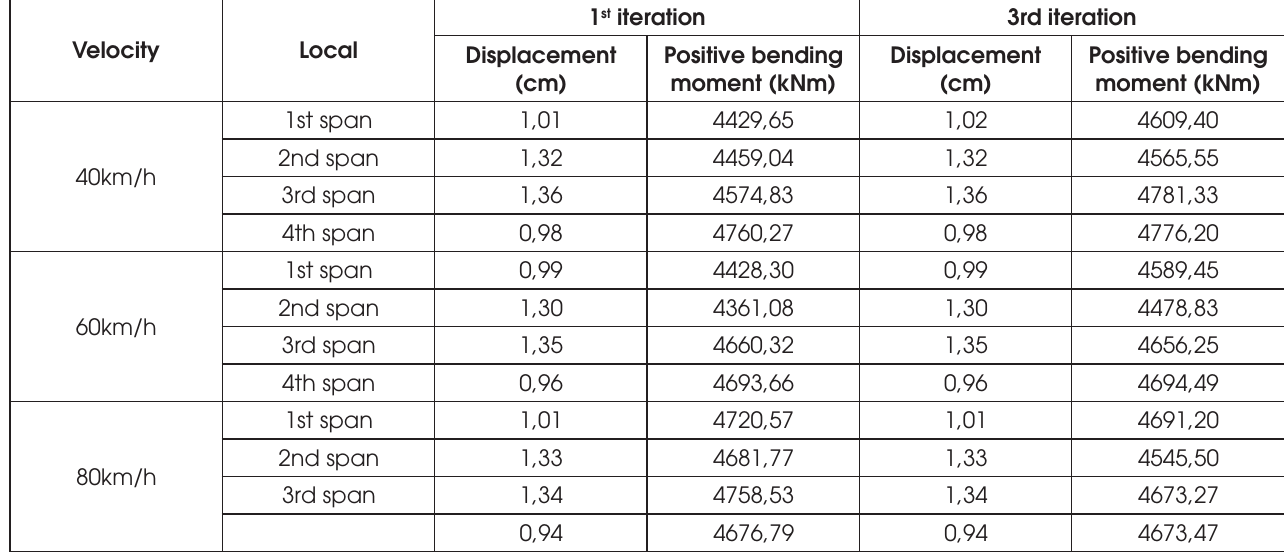
Displacements and positive bending moments – 1 st and 3 rd iteration